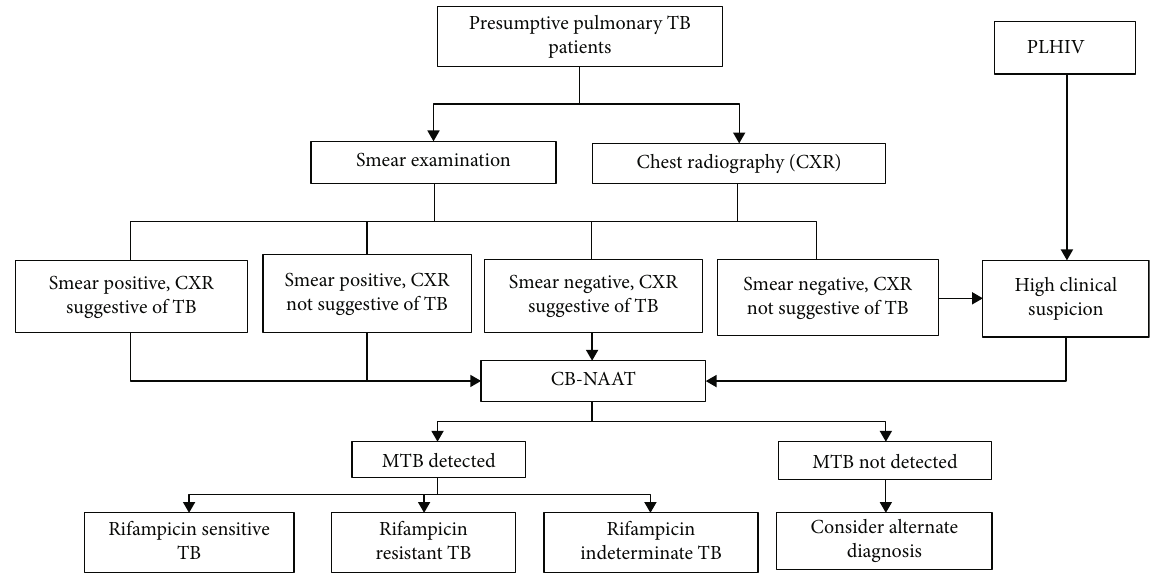
Figure 1: Recommendations for chest radiography and CB-NAAT for the evaluation of presumptive pulmonary TB patients as per the integrated diagnostic algorithm of the Government of India's Revised National TB Control Programme